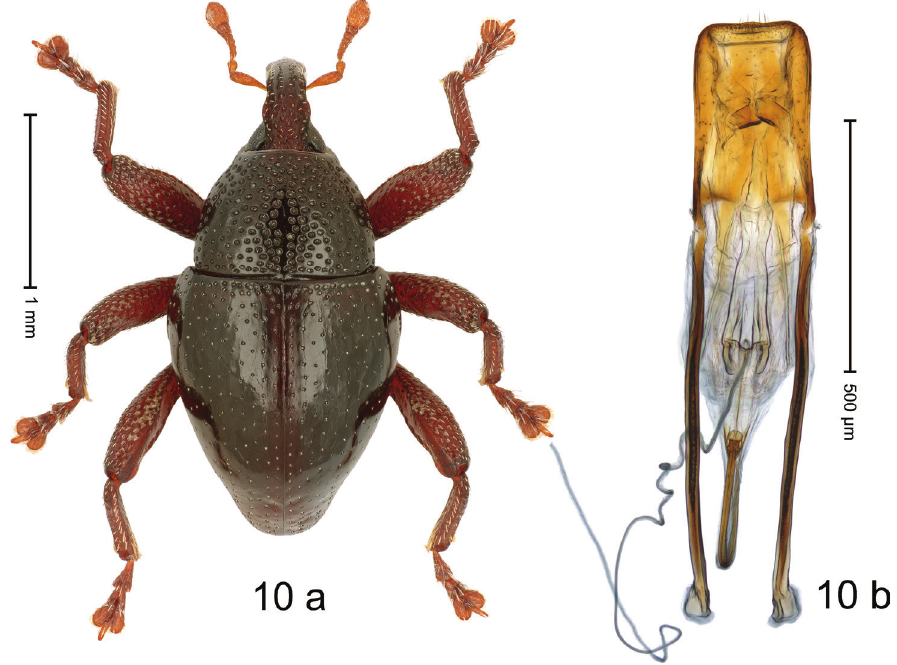
Figure 10. Trigonopterus kakimerah sp. nov., holotype a habitus b penis.